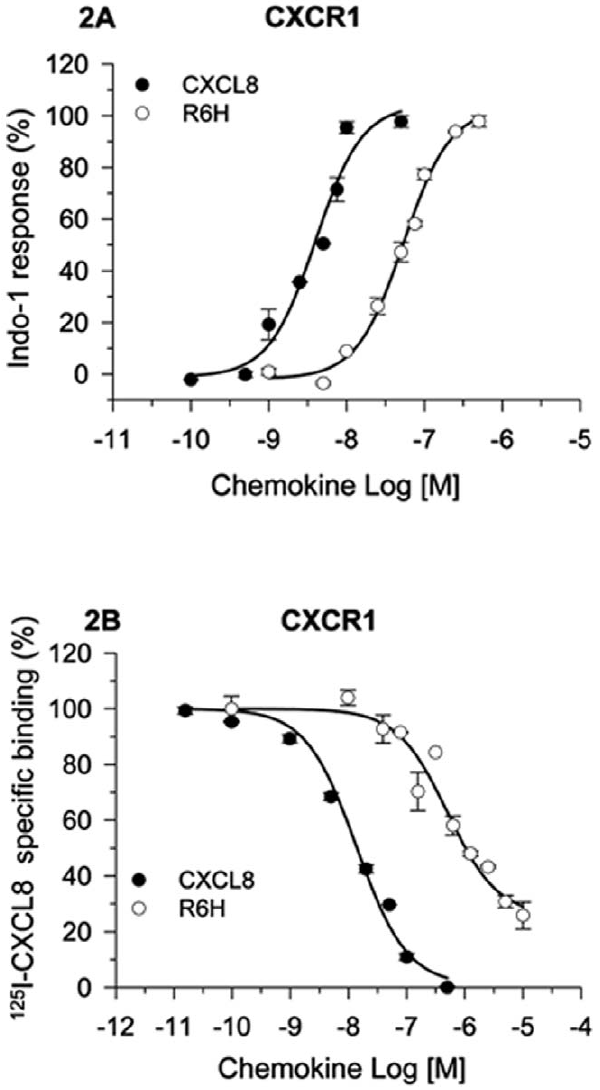
Figure 2. R6H-CXCL8 is a full CXCR1 agonist and binds to HL60 cells expressing CXCR1. A. Dose-dependent calcium responses in HL-60 cells expressing CXCR1. HL-60 cells expressing CXCR1 loaded with Indo-1 were stimulated with different concentrations of wild-type CXCL8 or R6H-CXCL8 mutant. The intracellular calcium response stimulated by 100 nM CXCL8 is referred as 100%. The EC 50s of R6H- CXCL8 and CXCL8 were 54 nM and 4 nM, respectively. Values are means of triplicate determinations, and the bars of each point represent the standard errors B. HL-60 cells expressing CXCR1 or CXCR2 were incubated with 125 I-CXCL8 (0.16 nM) in the absence or presence of increasing concentrations of unlabeled CXCL8 or R6H-CXCL8 mutant at 4 u C for 5 h. The 100% specific binding corresponded to the binding of 125 I-CXCL8 in the absence of unlabeled chemokine minus the binding of 125 I-CXCL8 in the presence of 200 nM of unlabeled CXCL8. The IC50s for R6H-CXCL8 and CXCL8 were 504 and 14 nM, respectively. Values are means of triplicate determinations, and the bars of each point represent the standard errors.